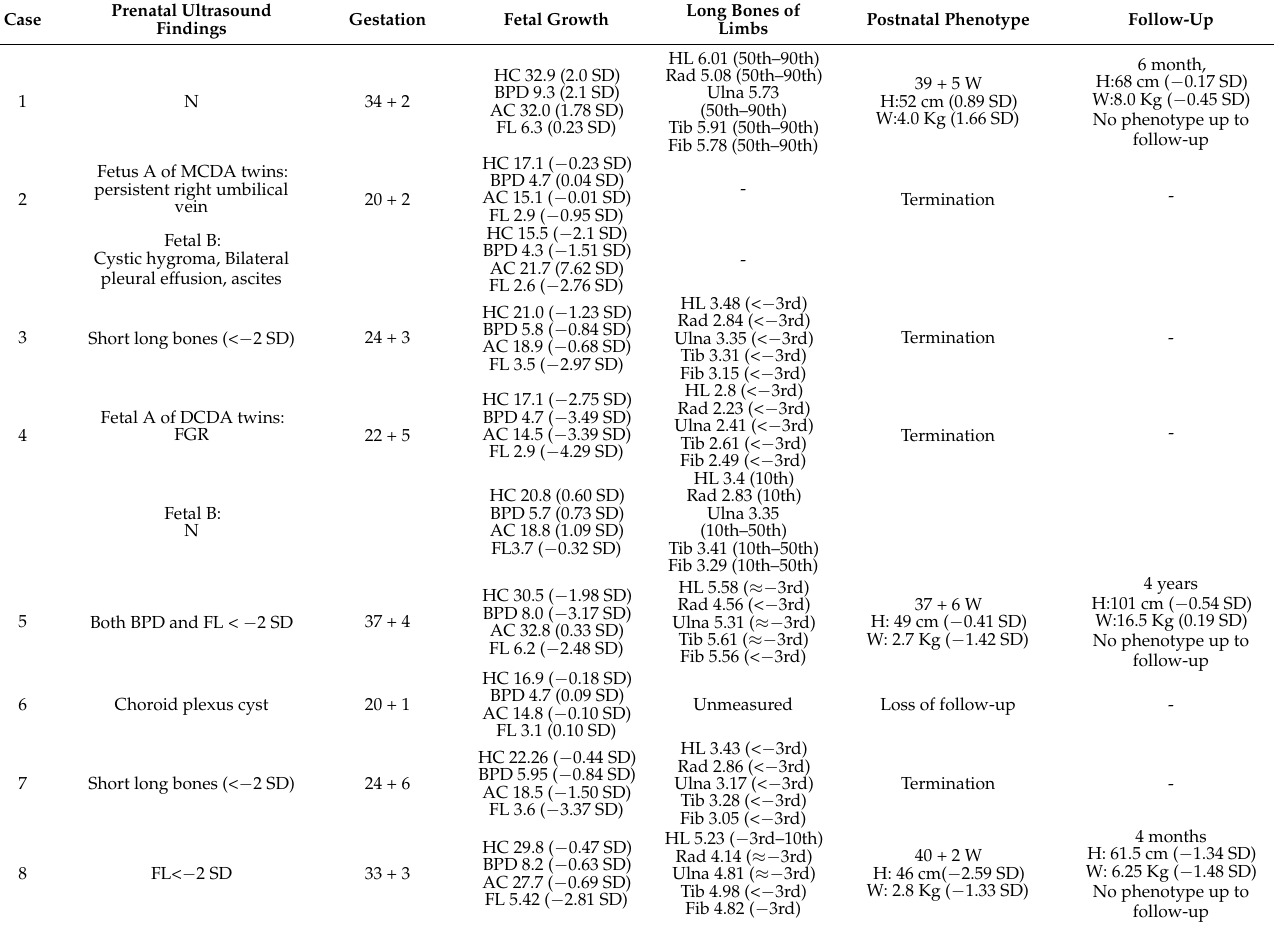
Table 2. Intrauterine and postnatal phenotypes of SHOX haploinsufficiency